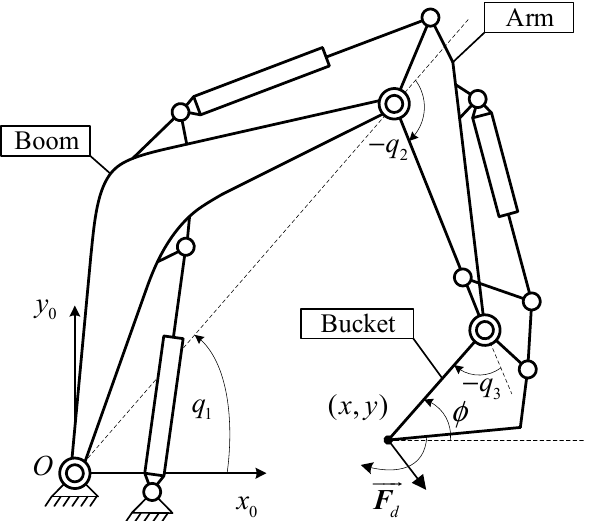
Figure 1. Excavator model [4], Reprinted/adapted with permission from Ref. [4]. 2021, Elsevier.